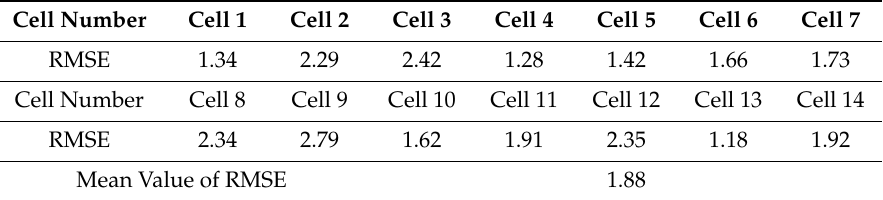
Table 5. RMSE of state jump observer.